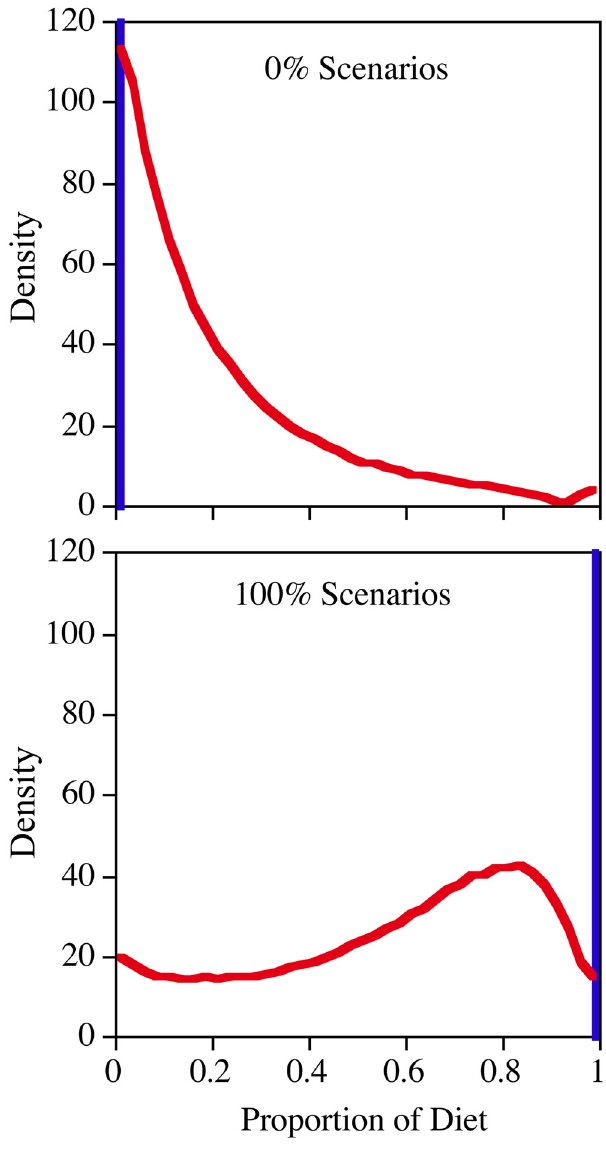
Fig 2. The results of an analysis where three potential food resources were either set to 100% of the food consumed or 0% ( e . g ., 100% diatoms, 0% green algae, and 0% cyanobacteria). This resulted in 9 outputs for the three SI based analyses (red). Because the outputs for the three SI cases where the subsidy should have been 100% were very similar, as was also true for the six cases where the subsidy should have been 0%, the three 100% responses and the six 0% responses were aggregated in this plot. For the FA based analyses (blue), we simply analyzed the original 10 cases where Daphnia consumed diatom monocultures. We also analyzed the 8 cases where the Daphnia consumed green algae monocultures as well as the 8 cases where they consumed cryptophyte monocultures. In these 26 cases, the correct answer was always obtained to multiple decimal places. The curves represent the 1/10 th percentile (n = 1000) density distribution of the model posterior densities grouped into 40